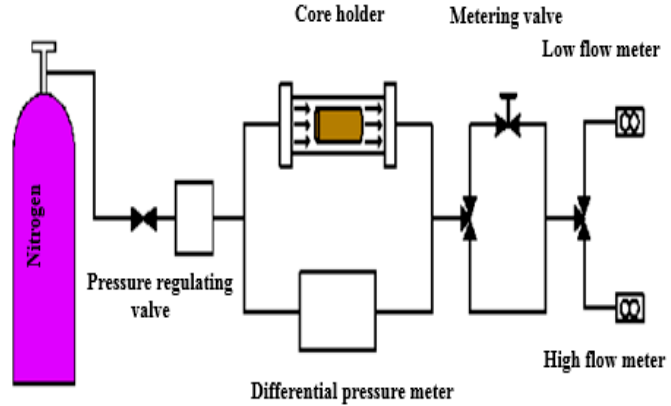
Figure 8. The diagram of the low permeability measurement instrument.